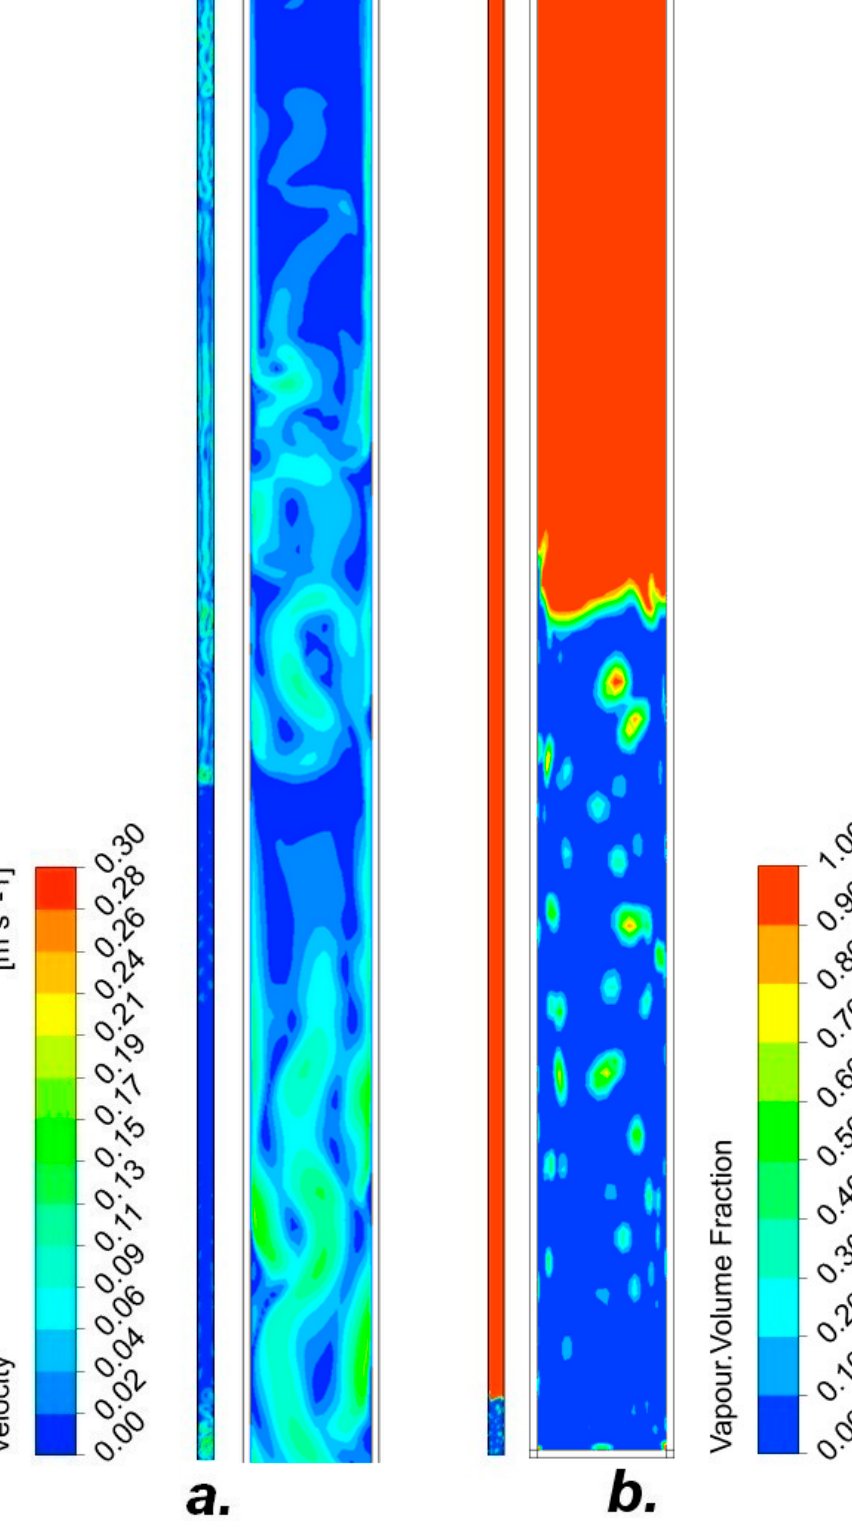
Figure 8. ( a ) Fluid velocity in the total heat pipe and in the condenser section, ( b ) the volume fraction of steam in the total heat pipe and in the evaporator section.